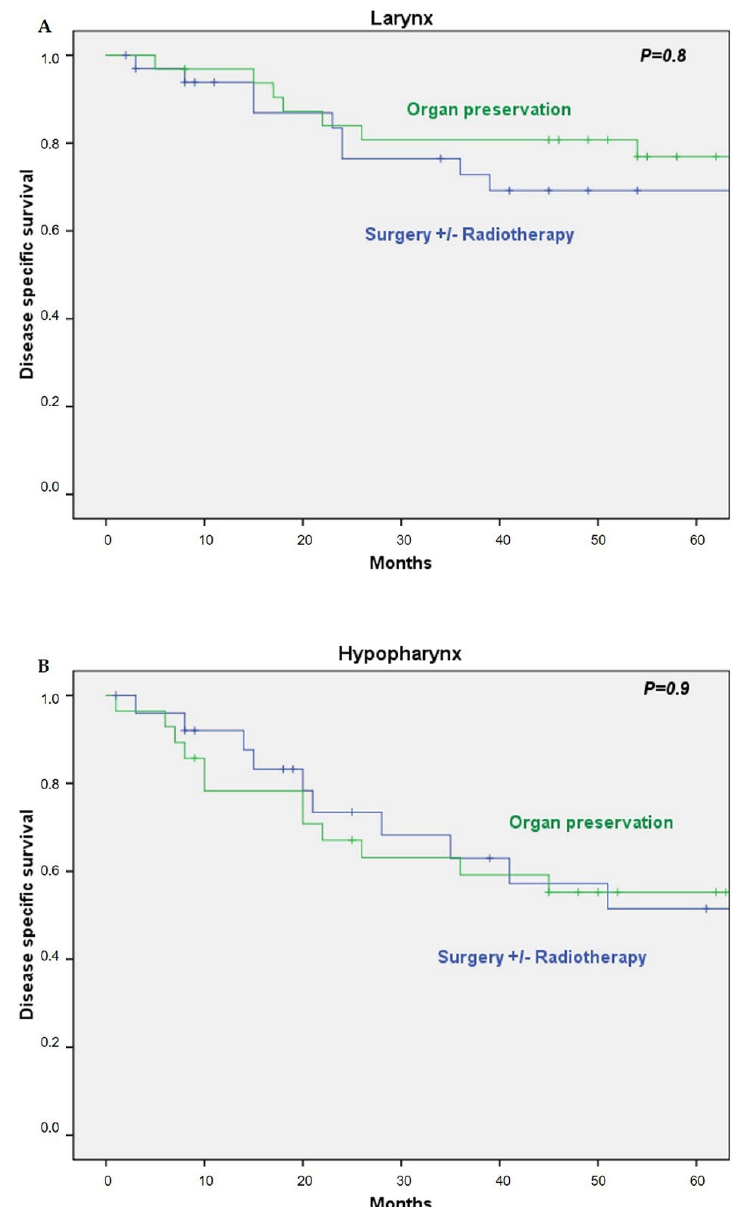
Figure 3. ( A ) Disease-specific survival by treatment in the larynx; ( B ) disease-specific survival by treatment in the hypopharynx.